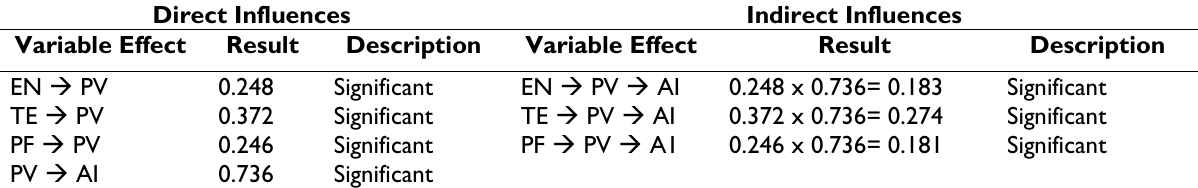
Table 7. Results of Direct and Indirect